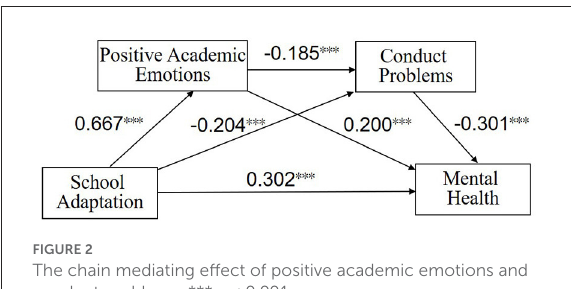
FIGURE2 The chain mediating effect of positive academic emotions and conduct problems. *** p ≤